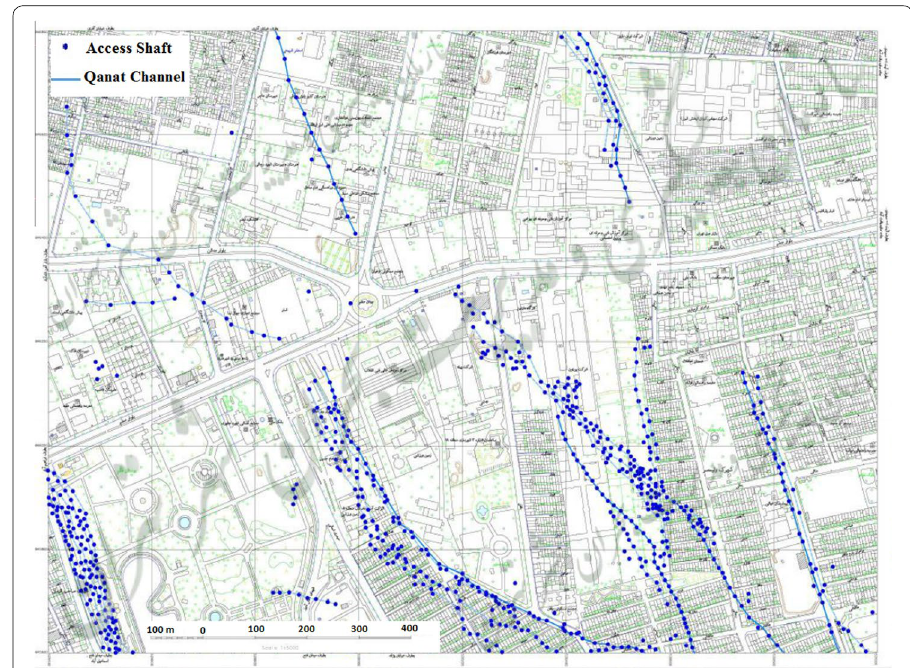
Fig. 3 Aqueduct map in parts of district 18, Tehran